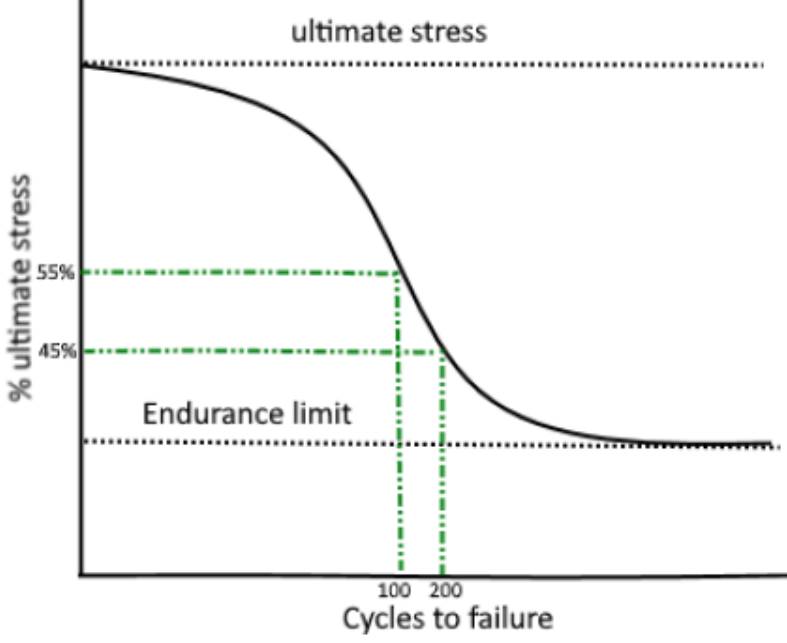
Figure 1. S-N curve for a biomaterial representing the basis of the fatigue failure theory. S is the percentage of ultimate stress and N is the number of cycles to